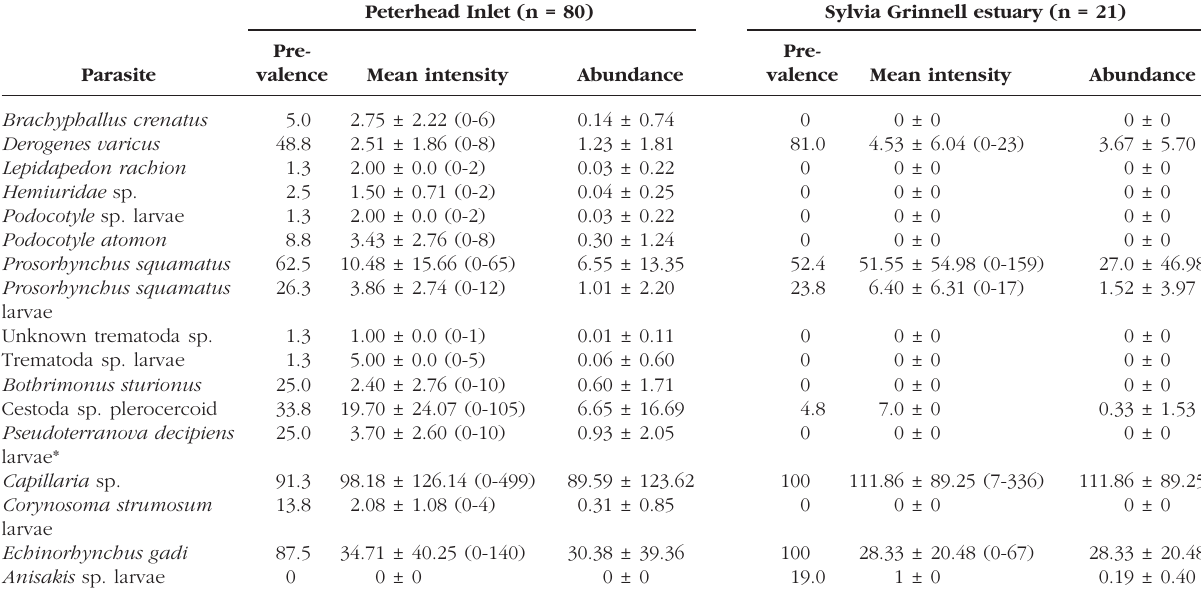
Table II. – Prevalence (%), mean intensity (± SD), with range in brackets, and abundance (± SD) of parasites in M. scorpius sampled from Peterhead Inlet and the Sylvia Grinnell River estuary,